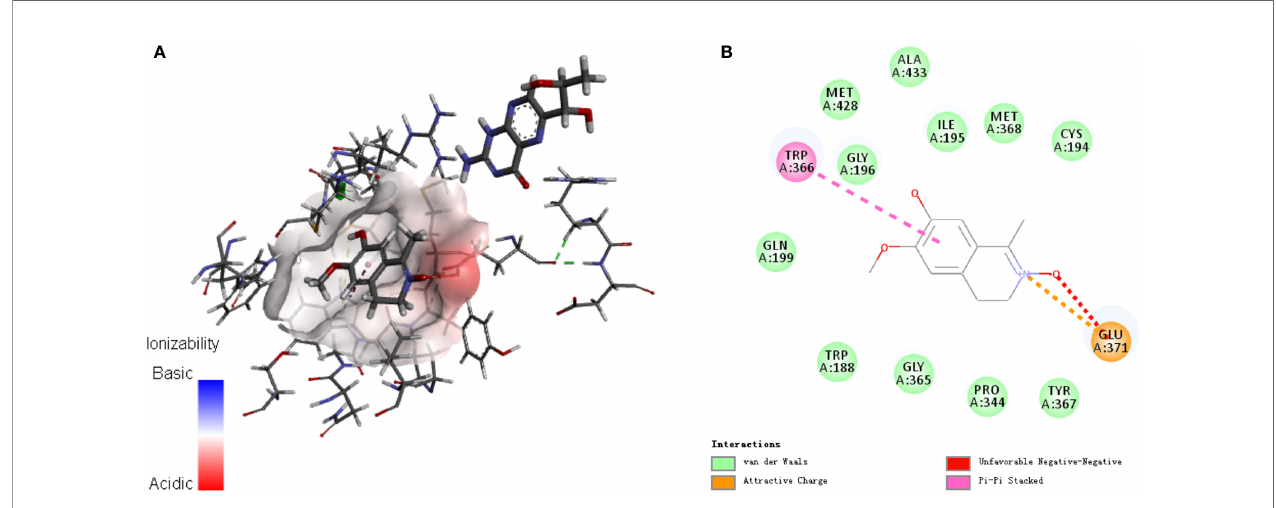
FIGURE 4 | Analysis of (A) active targets in the structure of LA and (B) simulation docking with the iNOS protein crystal structure. The results demonstrate that in theory, LA can directly bind the iNOS protein via interactions with TRP 366 and GLU371 residues for its inhibitory effect